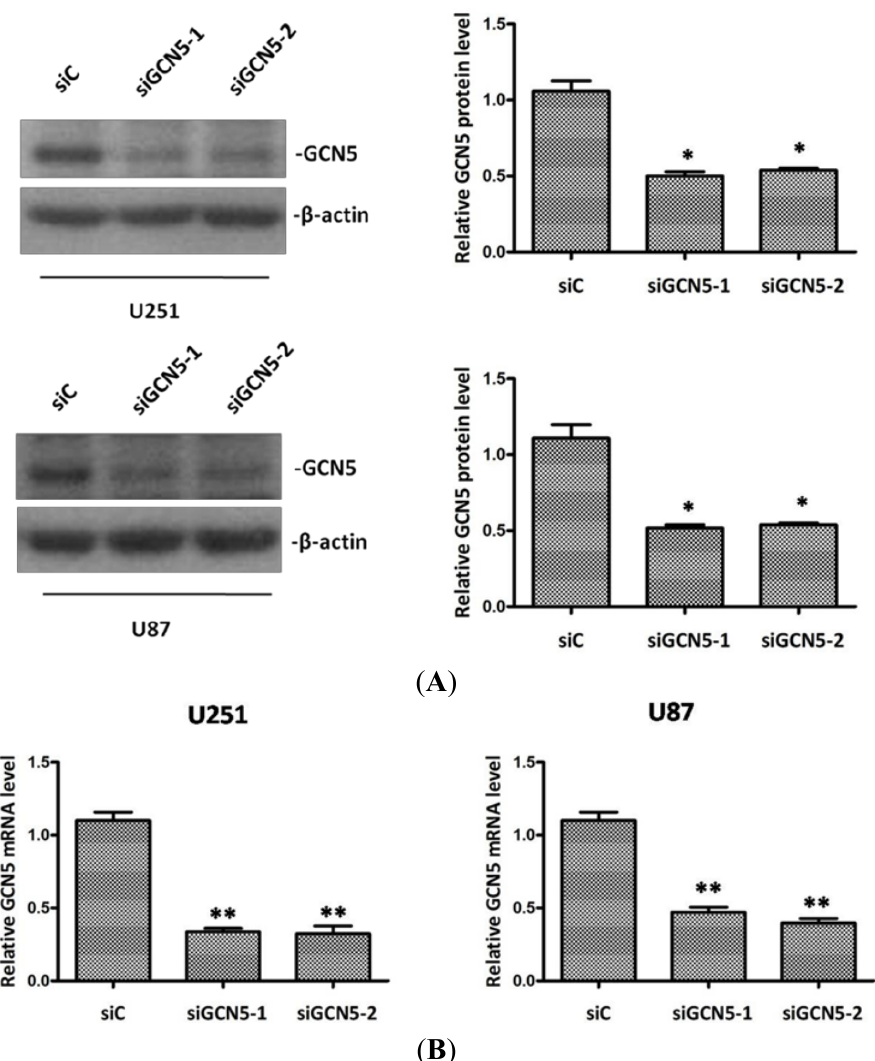
Figure 3. GCN5 expression was suppressed after siRNA treatment. ( A ) Western blot showed that GCN5 protein level was significantly decreased after siRNA